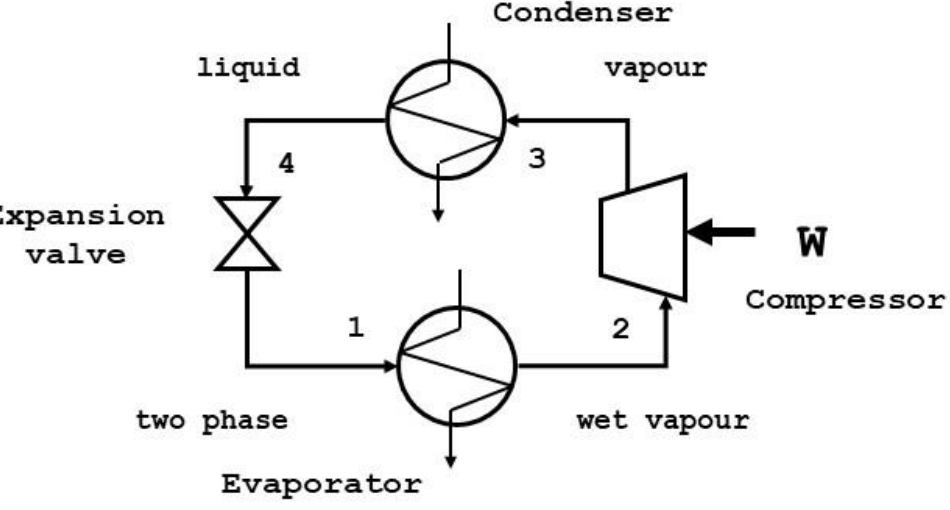
Figure 1. Diagram of the elements that make up a single-stage vapor compression heat pump. Numbers refer to the stages of the cycle.